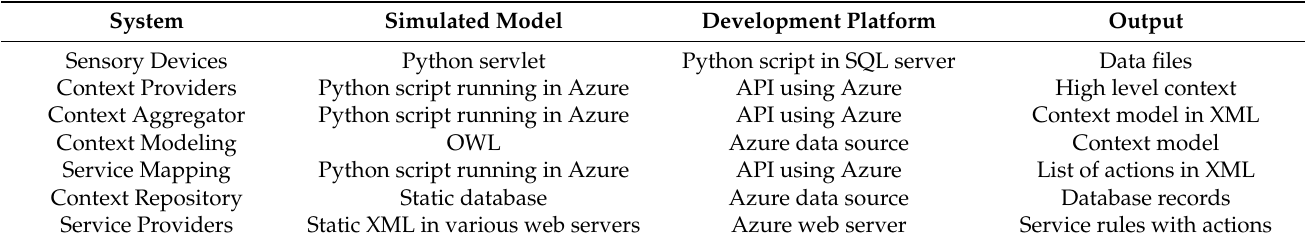
Table 5. Software features for the IoT middleware